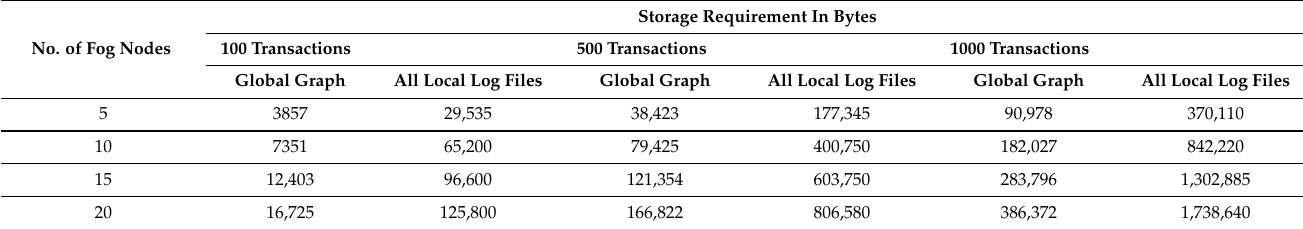
Table 5. Storage requirement in bytes for graph files with existing of trusted fog